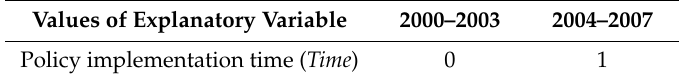
Table 8. The value of the policy implementation time under the time point